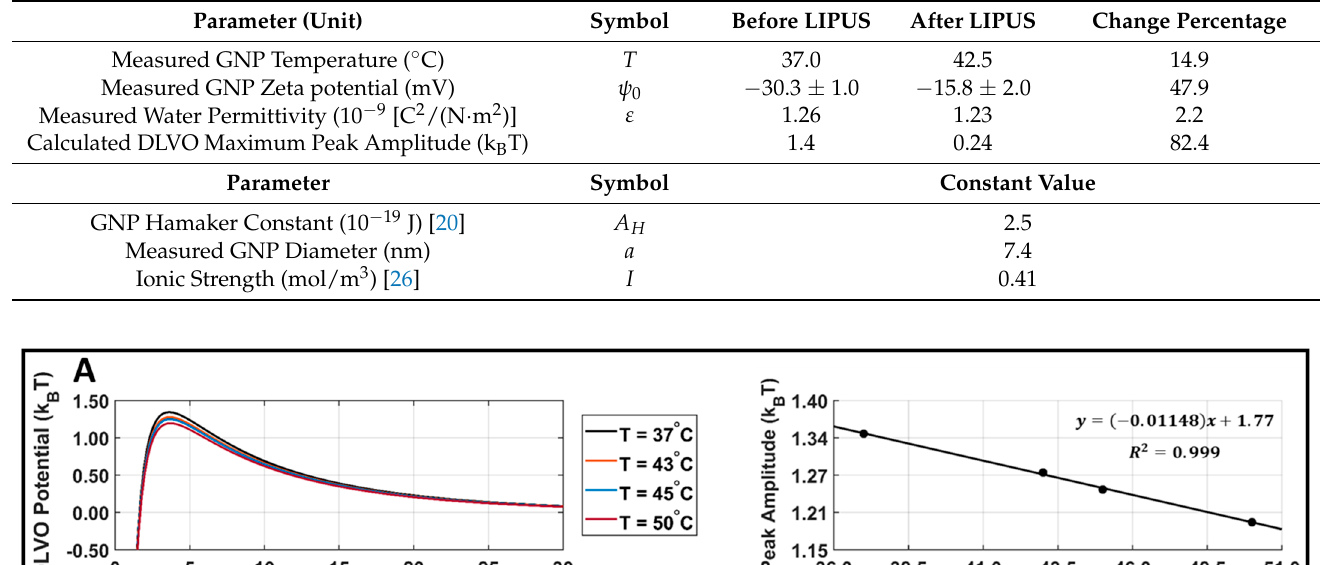
Table 2. Temperature-dependent DLVO parameters and constants used in the DLVO model.